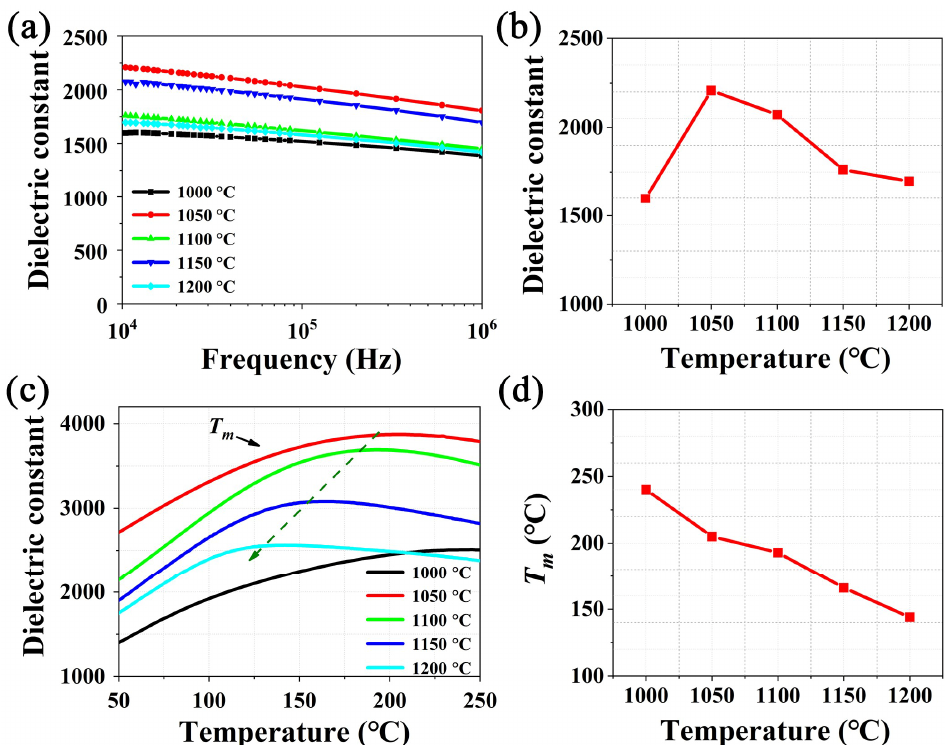
Figure 4. ( a ) Frequency dependent of the dielectric constant and ( b ) the corresponding change at 10 kHz for NBT-BT-NN ceramics. ( c ) Temperature dependence of dielectric constant and ( d ) the variation trend of T m for each ceramic.